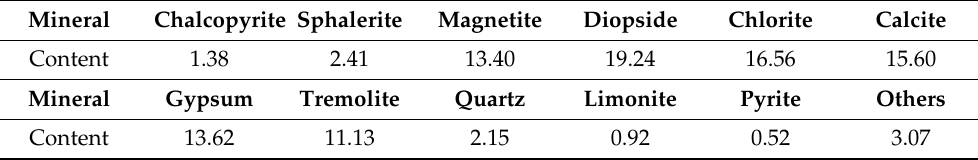
Figure 1. XRD spectrogram of the polymetallic ore. Table 2. Mineral composition of the polymetallic ore (%).